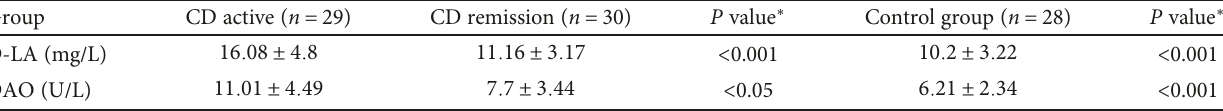
Table 2: Comparison of levels of D-LA and DAO among